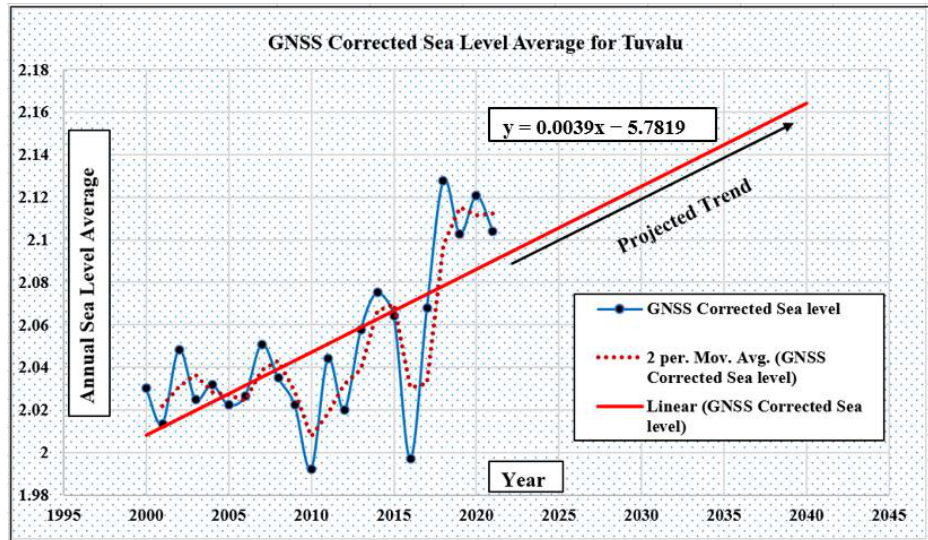
Figure 19. Annual GNSS VLM-corrected sea level average from 2001 to 2021 with 2 per moving average, and linear projection to the year 2040 for Tuvalu.